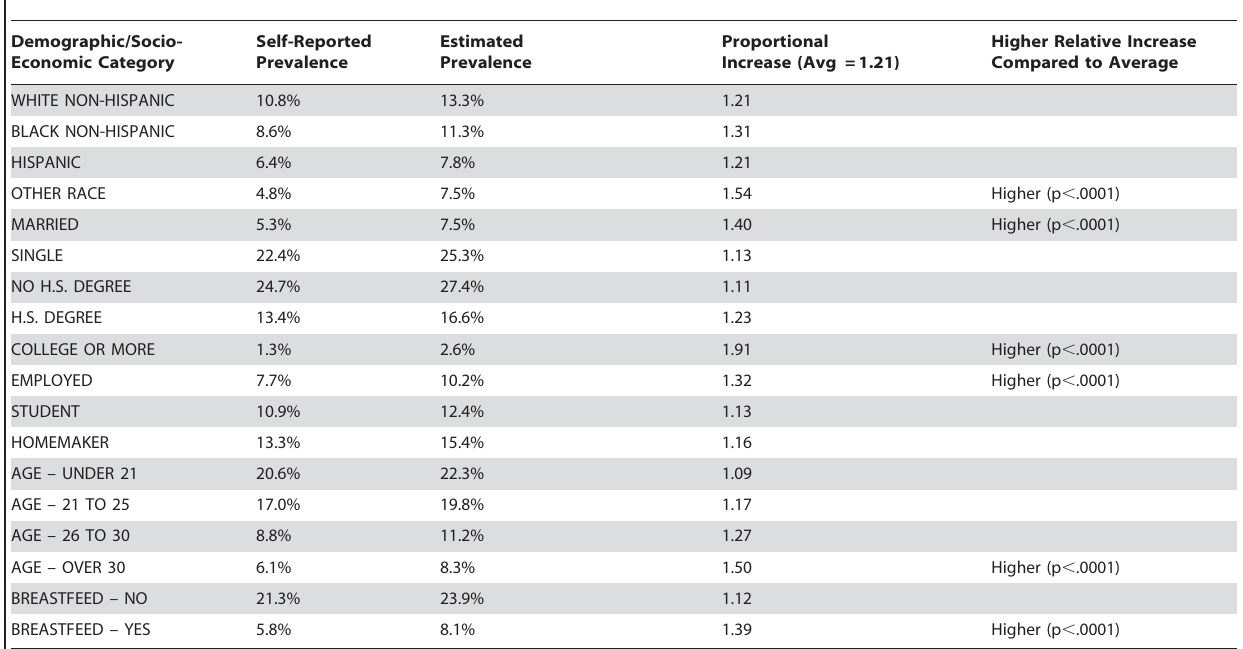
Table 2. Pattern of estimated underreports by demographic category for singleton births in Massachusetts (1997–2004) for 200 g effect size for smoking during